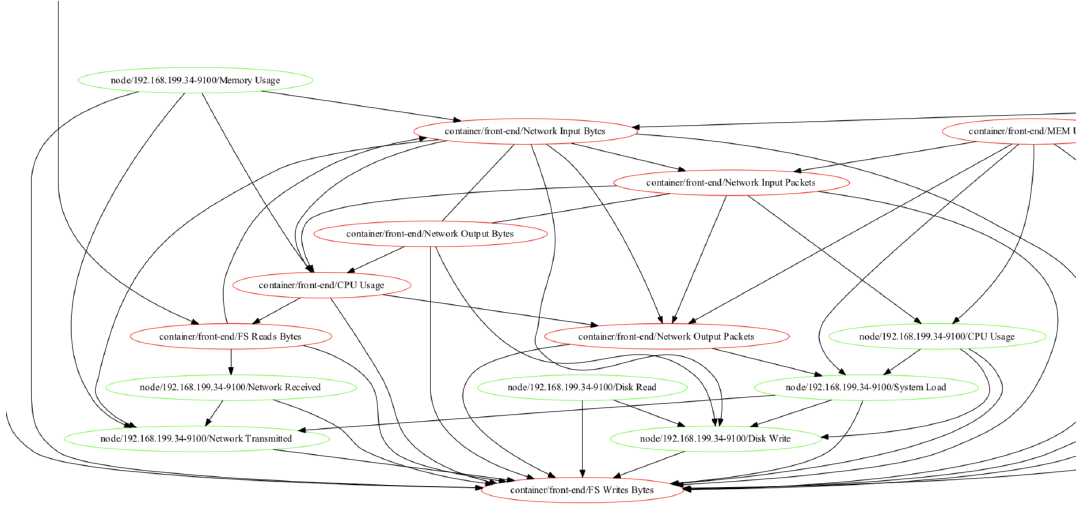
Figure 13. Part of causality graph for all performance